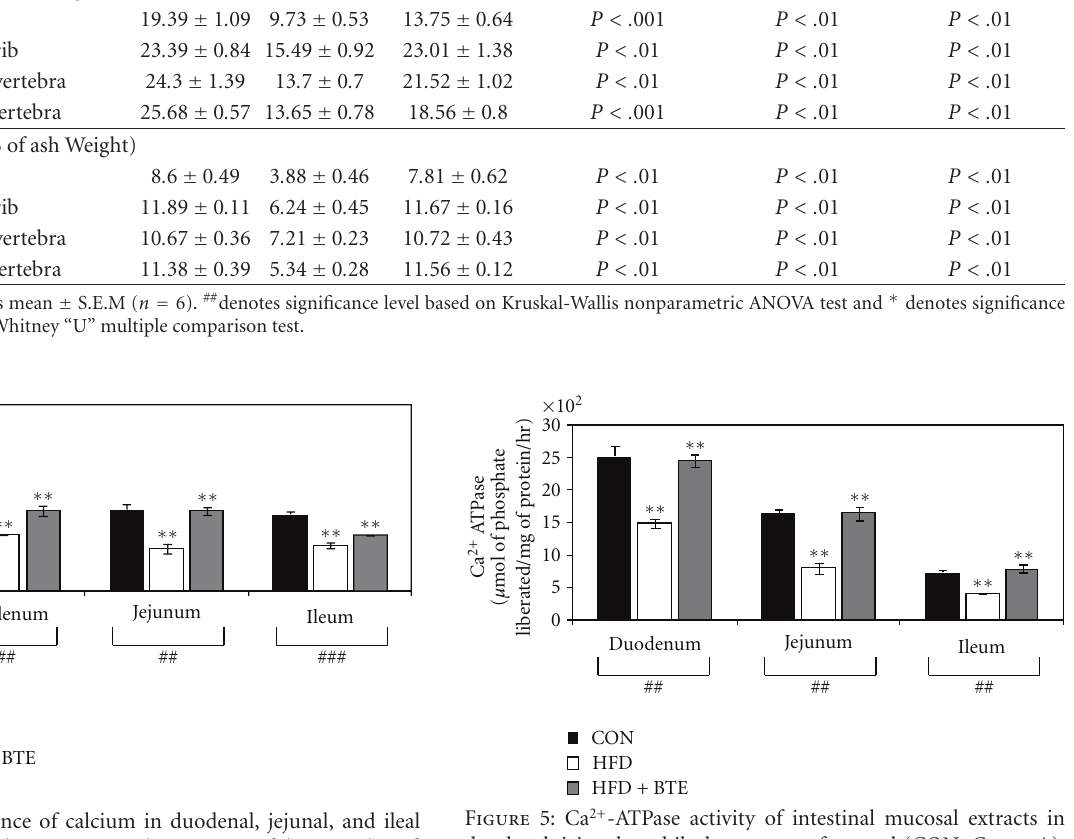
3.10. Intestinal Alkaline Phosphatase Activity. Figure 6 depicts that, compared to control group, HFD-fed